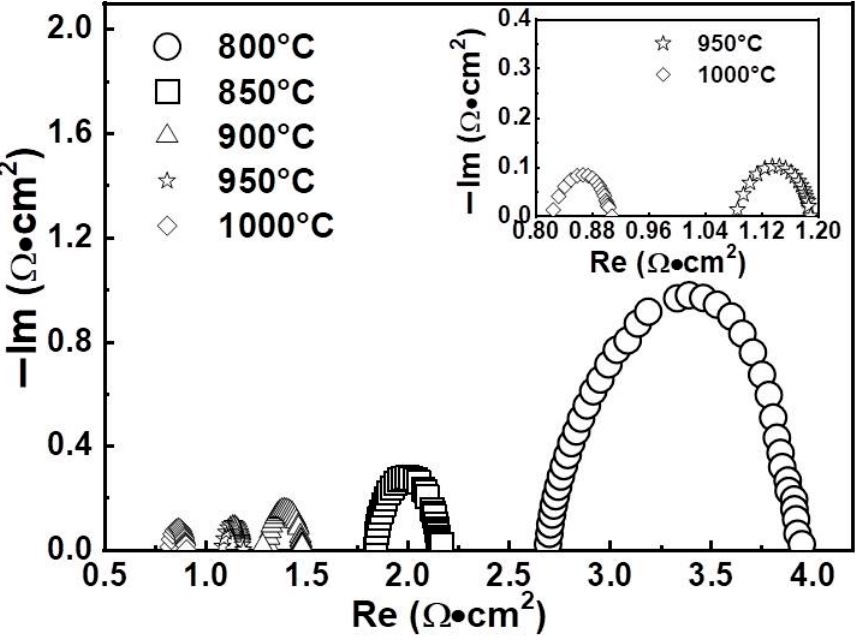
Figure 7. Nyquist diagrams of the YSZ/LSM composite cathode deposited by SPPS. Table 2. Comparison of polarization properties of YSZ/LSM and